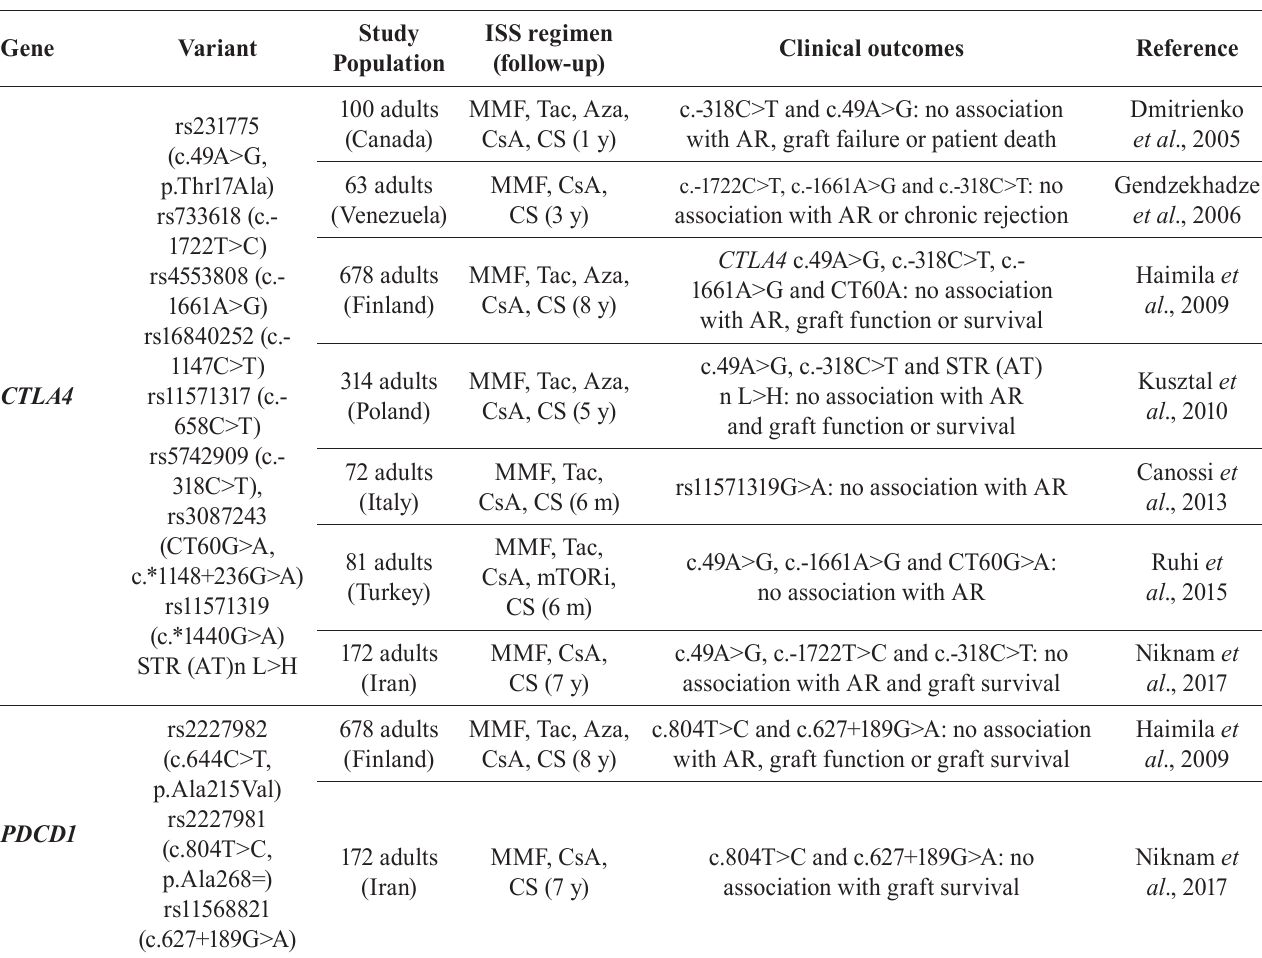
TABLE II - Genes related to T cell activation in kidney recipients on MPA therapy